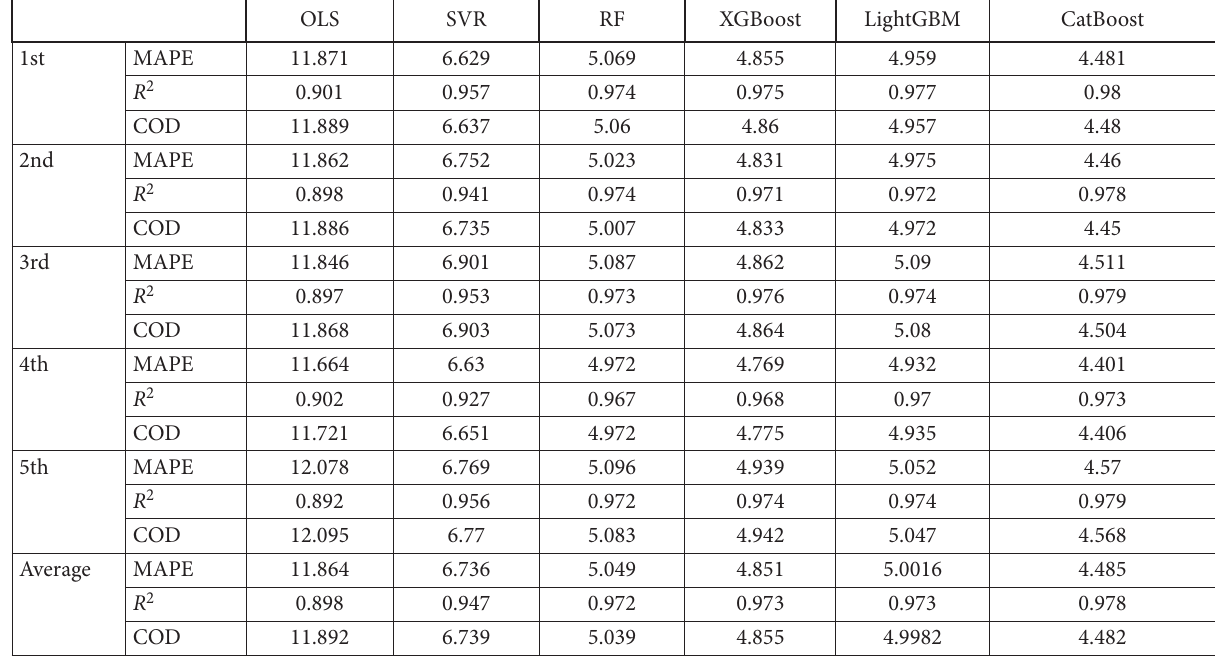
Table 3. Accuracy measurements: first-stage